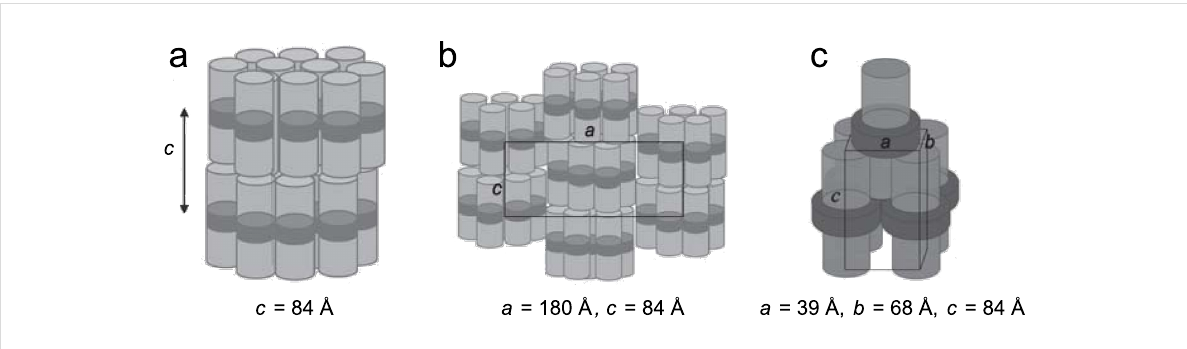
Figure 10: The proposed structural models resulting from ligand migration at the NP surface: (a) Smectic ( Au@C 6 /7 1,6 ) (b) modulated smectic Au@C 8 /7 1,6 , (c) columnar ( Au@C 12 /7 1,6 ). Light grey and dark grey indicate the disposition and form of the mesogenic groups and alkylthiols respect- ively. Reprinted with permission from [64]. Copyright 2010 Wiley-VCH Publishers.